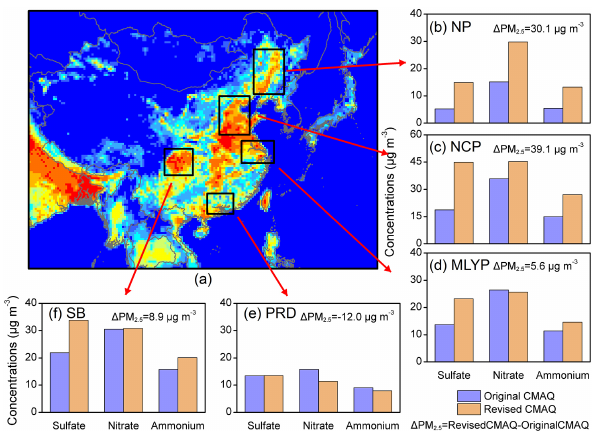
Figure 7. Comparison of predicted SNA from Original and Revised CMAQ for (b) NP, (c) NCP, (d) MLYP, (e) PRD and (f) SB. (a) Emission map of NH 3 in January 2013 at a horizontal resolution of 36km (source: MEIC